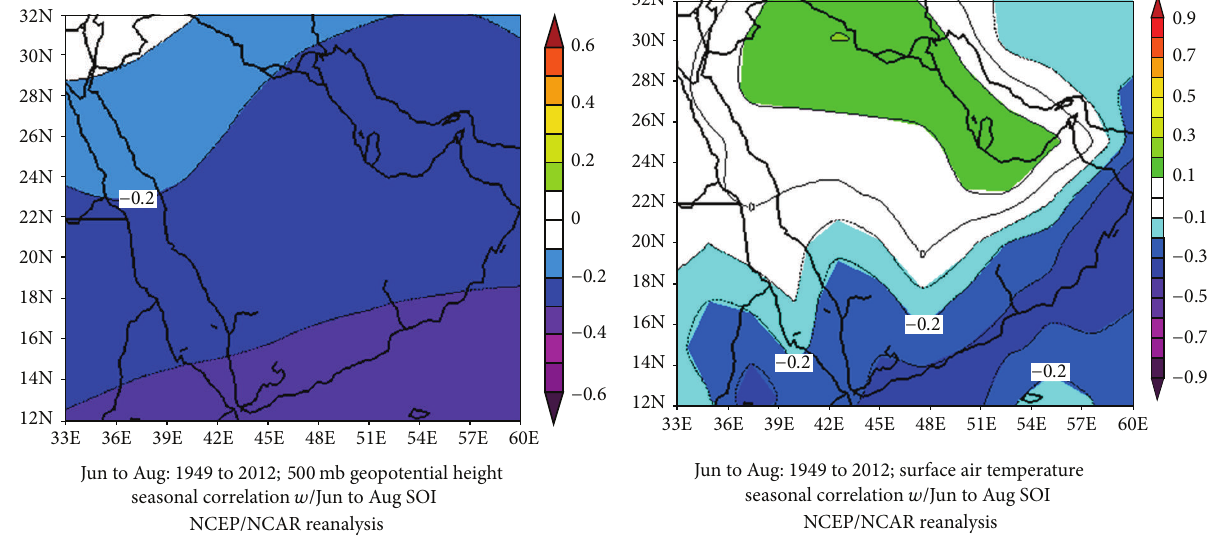
studied. The time series analysis of weekly data of weather elements over KSA and SOI was analyzed using